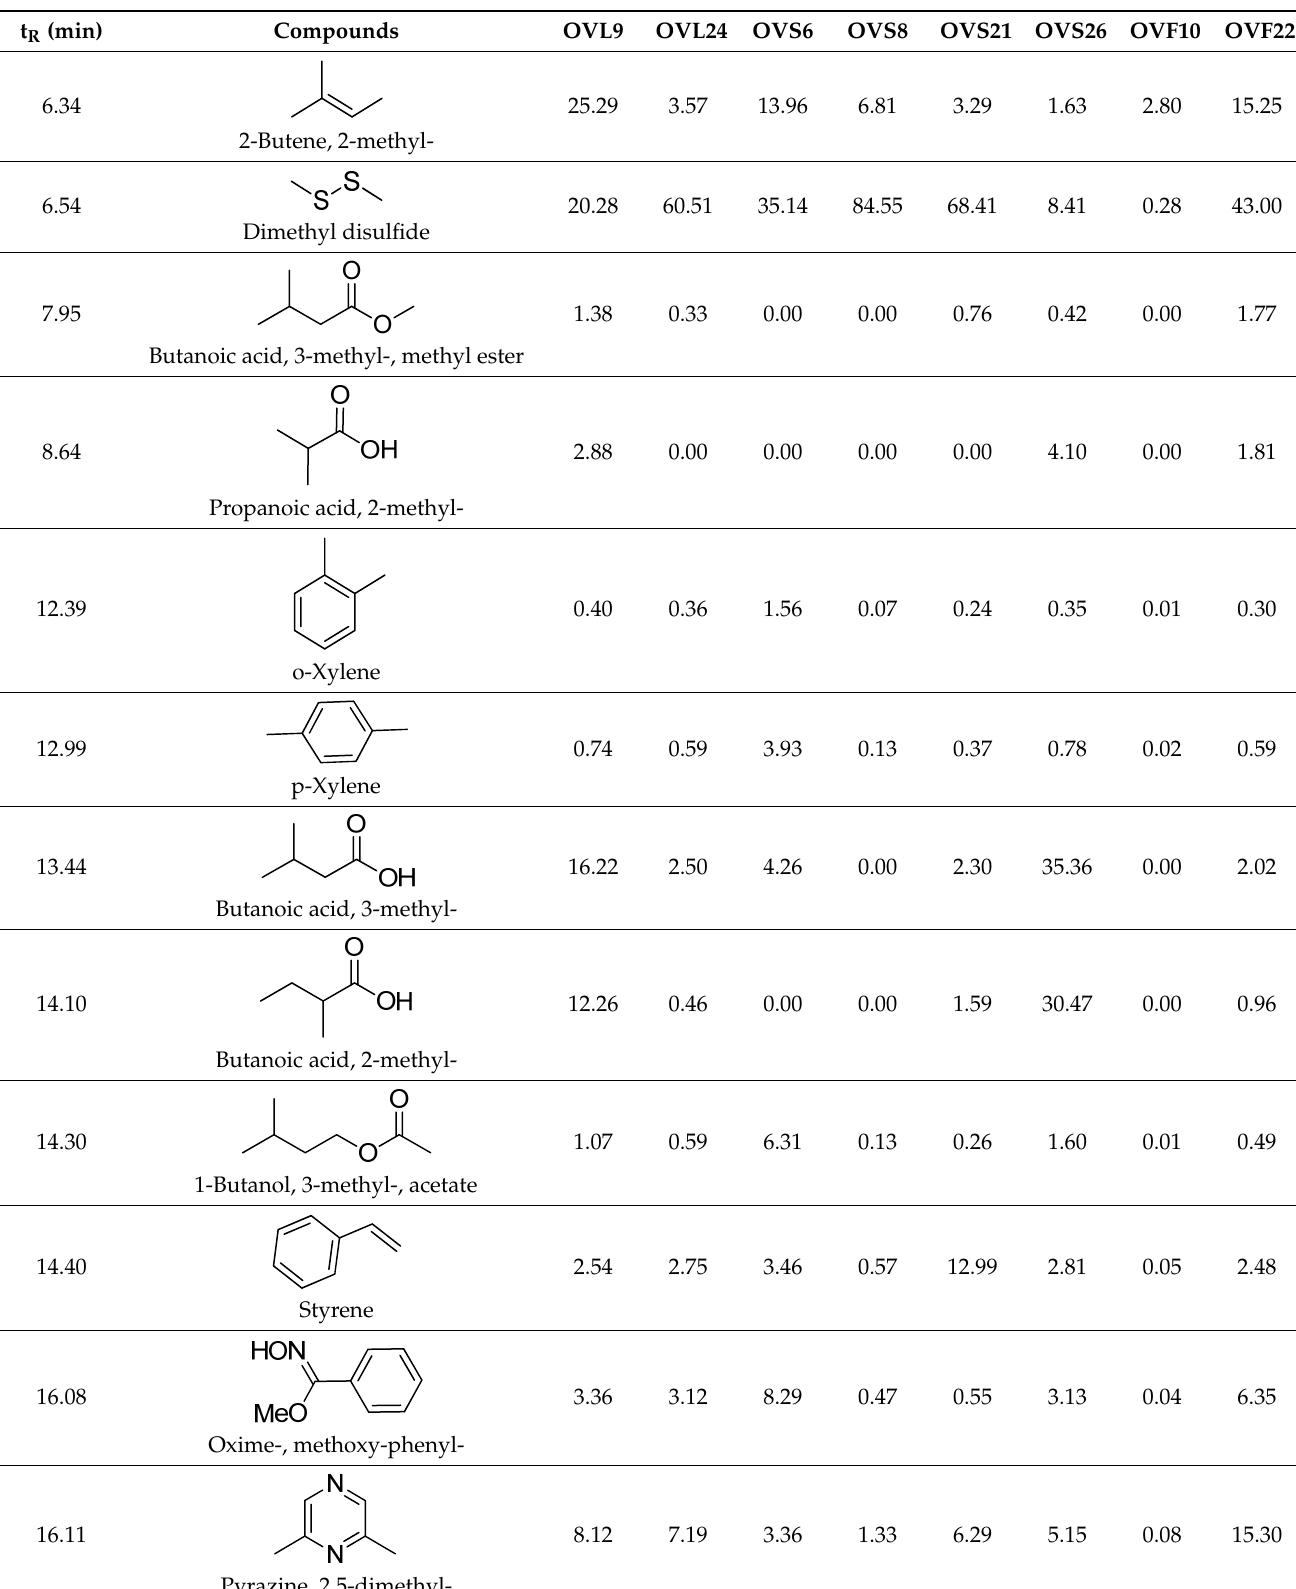
Table 2. Volatile organic compounds (VOCs) identified by SPME-GC/MS produced by O. vulgare ssp. vulgare endophytic strains. Results are expressed as mean relative abundance percentages (as obtained by dividing the area of each peak by the total area of the chromatogram peaks).